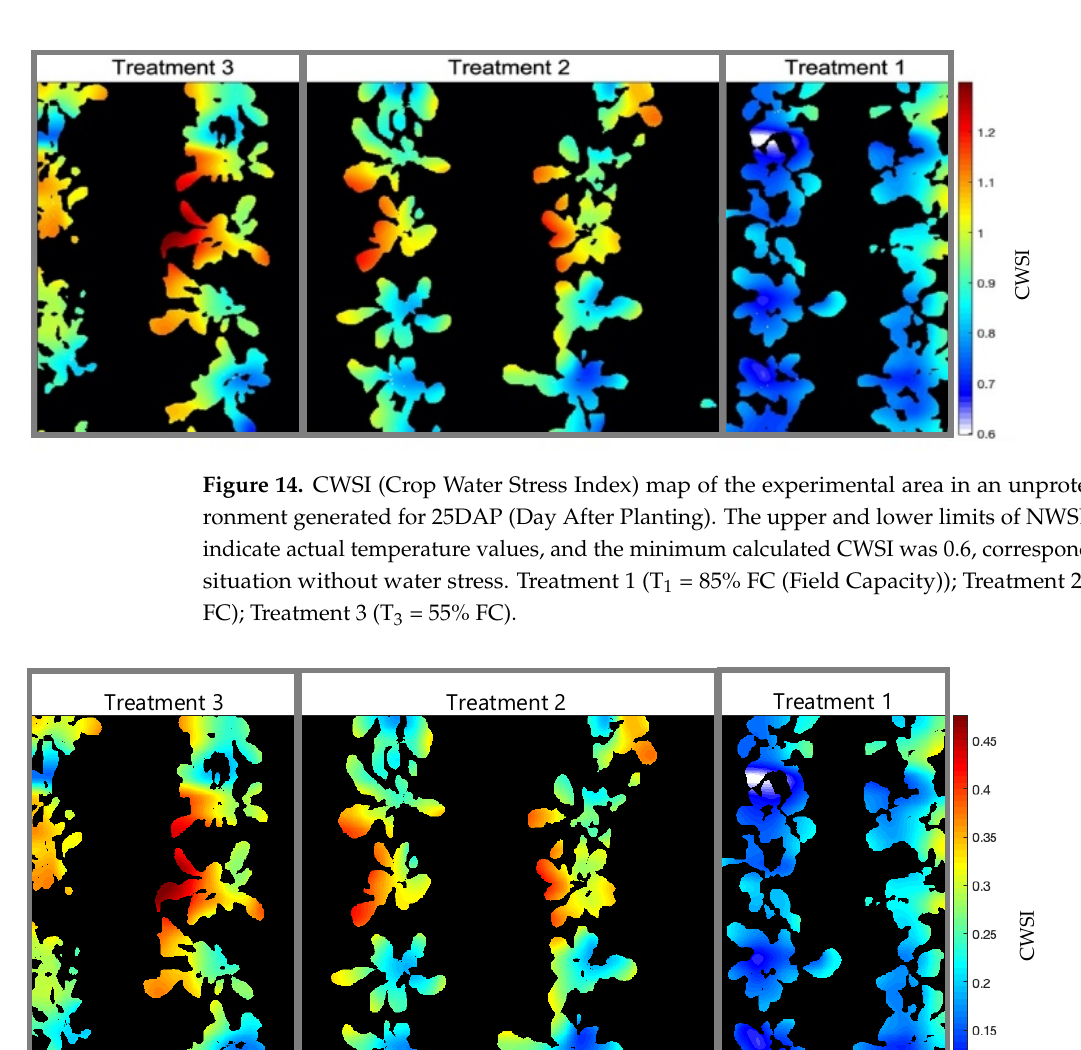
Figure 14. CWSI (Crop Water Stress Index) map of the experimental area in an unprotected envi- ronment generated for 25DAP (Day After Planting). The upper and lower limits of NWSB D did not indicate actual temperature values, and the minimum calculated CWSI was 0.6, corresponding to the situation without water stress. Treatment 1 (T 1 = 85% FC (Field Capacity)); Treatment 2 (T 2 = 75% FC); Treatment 3 (T 3 = 55% FC).